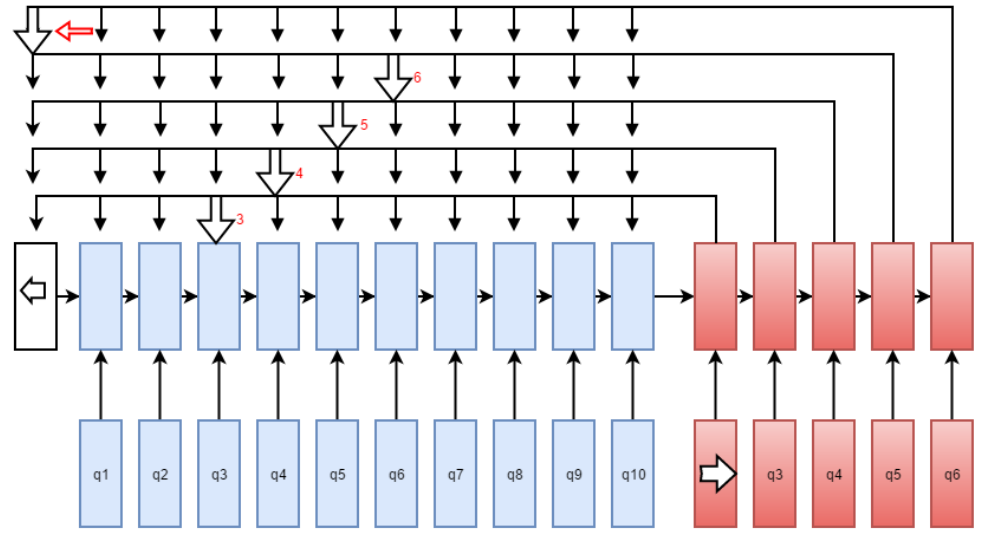
Figure 12. Solving the maximum clique problem (MCP) using pointer networks (encoder in blue, decoder in